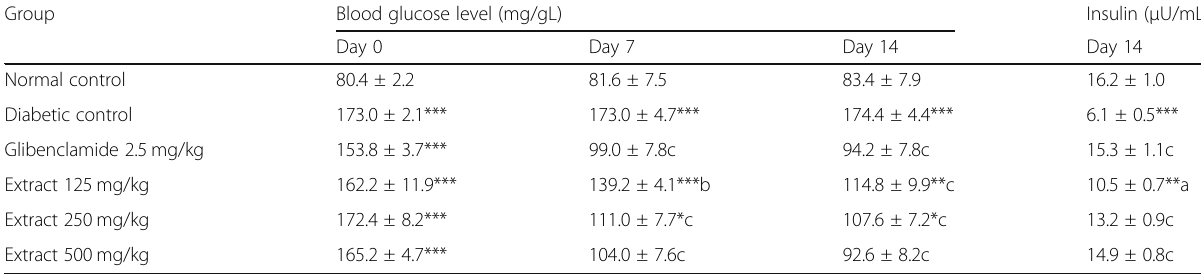
Table 2 Effect of Vitellaria paradoxa on fasting blood glucose and serum insulin levels in alloxan-induced diabetic rats